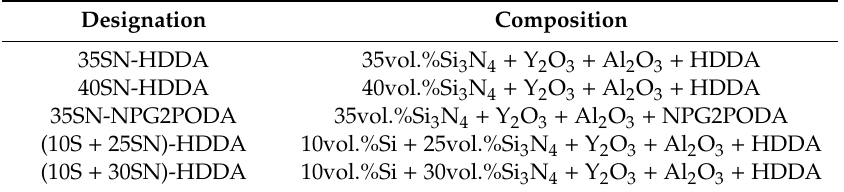
Table 2. Designations and corresponding compositions of slurries used in this experiment.